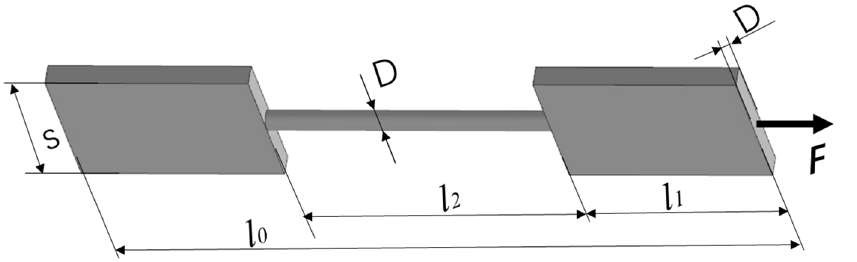
Figure 11. ( a ) Tensile strength-inclination angle curves with different diameter. ( b ) Coupled influence of the inclination angle θ and design diameter D on the tensile strength of rod unit.